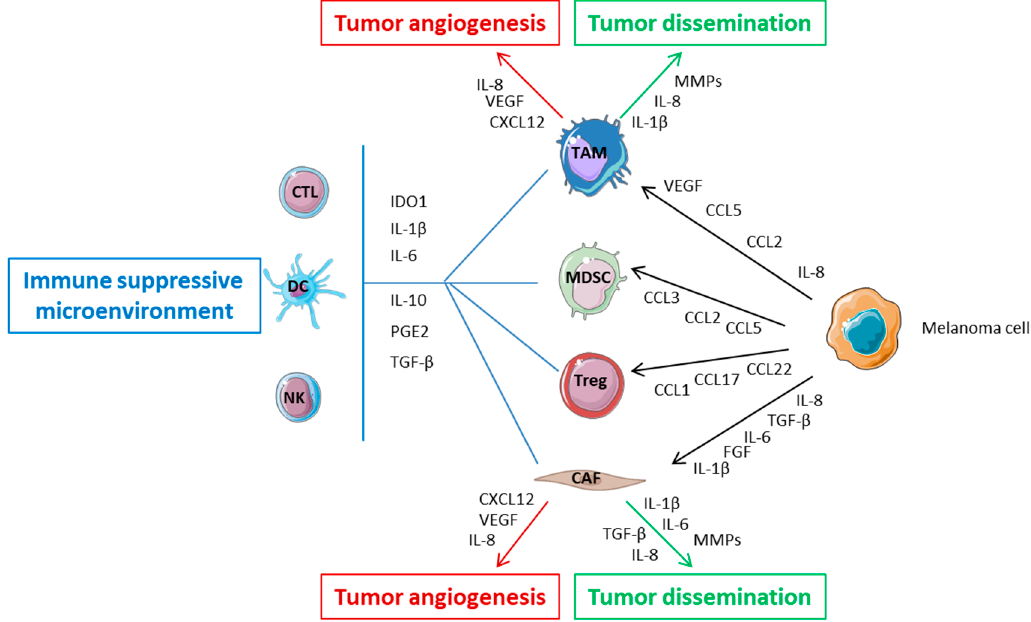
Figure 2. Melanoma cells modulate the communications with cells of the tumor microenvironment through the release of soluble factors in order to promote tumor dissemination, angiogenesis and the establishment of an immune suppressive niche. Cytotoxic T lymphocyte (CTL), dendritic cell (DC), natural killer cell (NK), tumor-associated macrophage (TAM), myeloid-derived suppressor cell (MDSC), T regulatory cell (Treg), cancer-associated fibroblast (CAF), interleukin 8 (IL-8), 1 β (IL- 1 β ), 6 (IL-6), 10 (IL-10), prostaglandin E2 (PGE2), C-X-C motif chemokine 12 (CXCL12), vascular endothelial growth factor (VEGF), tumor growth factor β (TGF- β ), metalloproteinases (MMPs), fi- broblast growth factor (FGF) and chemokine C-C ligand 1 (CCL1), 2 (CCL2), 5 (CCL5) and 17 (CCL17). Parts of the figure are drawn using pictures from Servier Medical Art (https://smart.ser- vier.com, (accessed on 18 December 2022). The establishment of an immunosuppressive microenvironment is also mediated by the upregulation of the inhibitory immune checkpoints (PD-L1/PD-1, CTLA-4, TIGIT, LAG-3) by melanoma cells or those of the surrounding microenvironment [11]. Currently, the relevance of NF-kB, JAK/STAT, and HIF pathways in the regulation of almost all of the above-mentioned mediators is now well established [12–14]. Taking advantage of these biological characteristics and the genetic background, mostly represented by BRAF mutations in about 50% of melanoma patients, immunotherapy and targeted therapy have been developed as standard therapies for melanoma patients with advanced disease. In particular, immunotherapy, a therapeutic approach boosting or suppressing the immune responses, represents a valid approach to treat melanoma through the inhibition of im- mune checkpoint inhibitors (ICI) or the modulation of cytokines/cytokine receptors axes [15]. Melanoma, as previously mentioned, is a skin cancer derived from neoplastic trans- formation of melanocytes, the cells specialized to synthetize and to package the melanin and to transfer it to dermal keratinocytes [16]. It is noteworthy that in mammalian mela- nocytes, two types of melanin with different behaviors are present, namely eumelanin and pheomelanin [17]. The quality and the amount of melanins confer the individual protec- tion to UV radiation and their role in melanoma progression has been recently reviewed [18,19]. The main role of melanin consists of photoprotection by filtering UV sun radiation [18] but it was demonstrated that the melanin’s role in skin is more complex. In fact, beside the UV filtering and reactive oxygen species (ROS) scavenging actions, other interesting functions have been demonstrated, since, for instance, it was shown that the presence of melanin was able to lower melanoma cell invasiveness by reducing cell elasticity and in- creasing cell stiffness [20]. On the other hand, the melanin modified by the UVB radiations